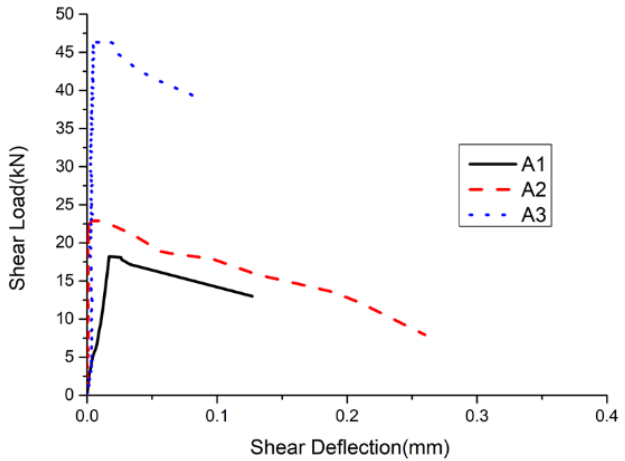
Figure 12. Shear load–deflection curves.